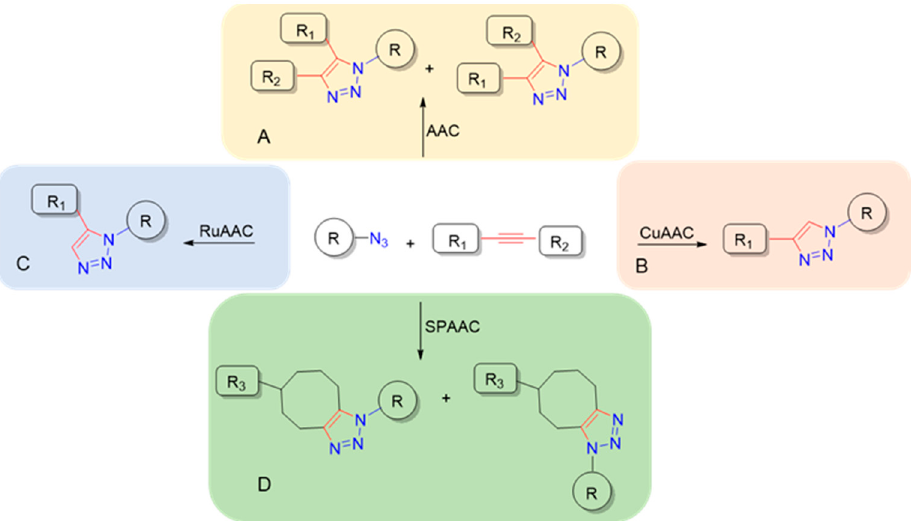
Figure 1. Synthetic routes to 1,2,3-triazoles: ( A ): R 2 = H, alkyl or aryl group; ( B , C ): R 2 = H; ( D ): R 1 = -(CH 2 ) 3 CH(R 3 )-R 2 -, R 2 = -(CH 2 ) 2 -R 1 -, R 3 = alkyl or aryl group.